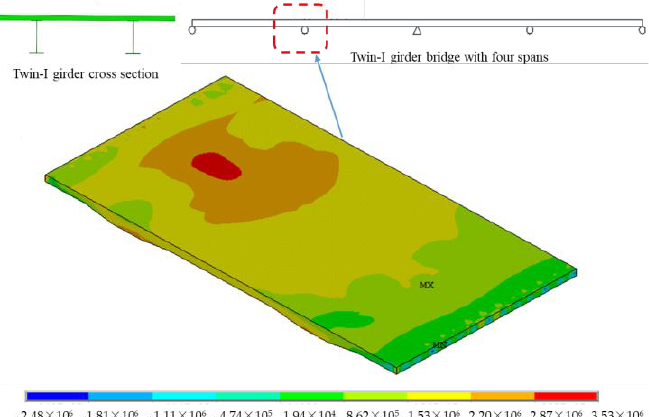
Figure 1. Stress distribution in the concrete deck under the short-term strength limit state (unit: Pa).